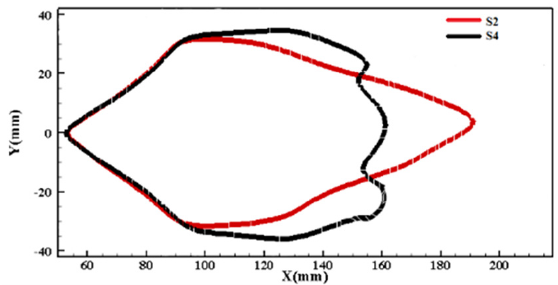
Figure 6. Comparison between the PRZ of Schemes S2 and S4.